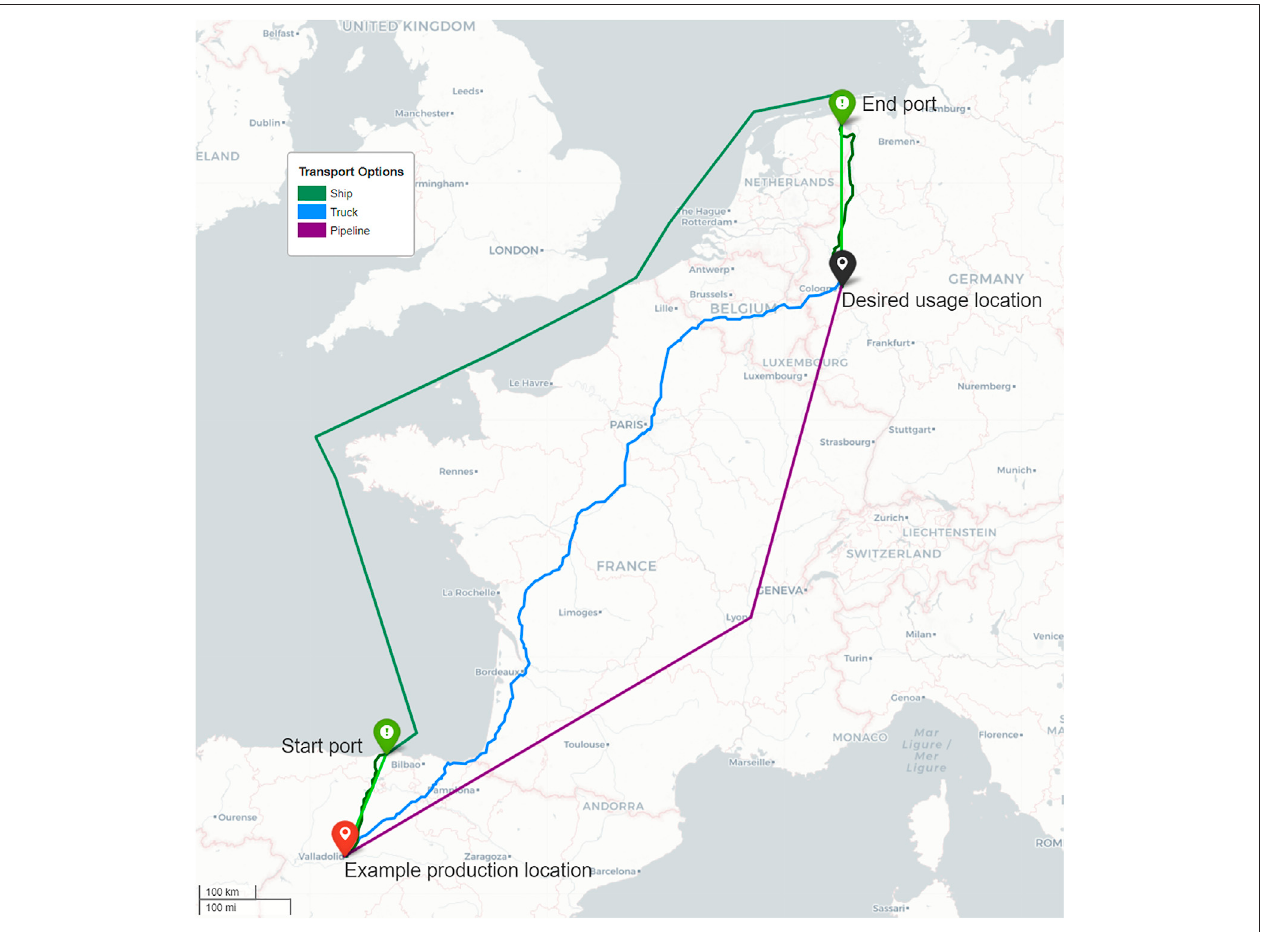
FIGURE4| Exampleshowingthepossibletransportoptionsfromtheproductionlocationstothedesiredusagelocation.H 2 canbetruckedorpipeddirectlytothe usage location, or it can be trucked or piped to the nearest port and shipped to the port closest to the usage location, from where it is trucked or piped to the usage location. The gaseous H 2 produced can be converted into other mediums at the production location or start port and re-converted at the end port or usage location.